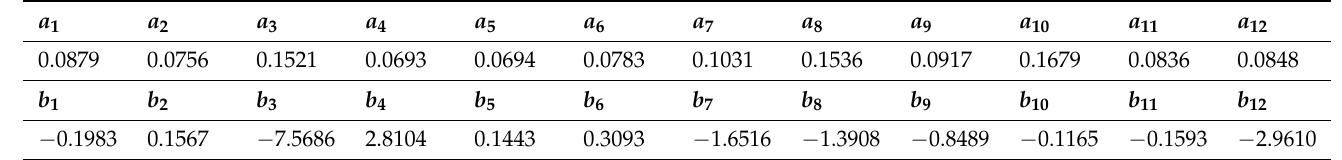
M from R 1 (drugs).